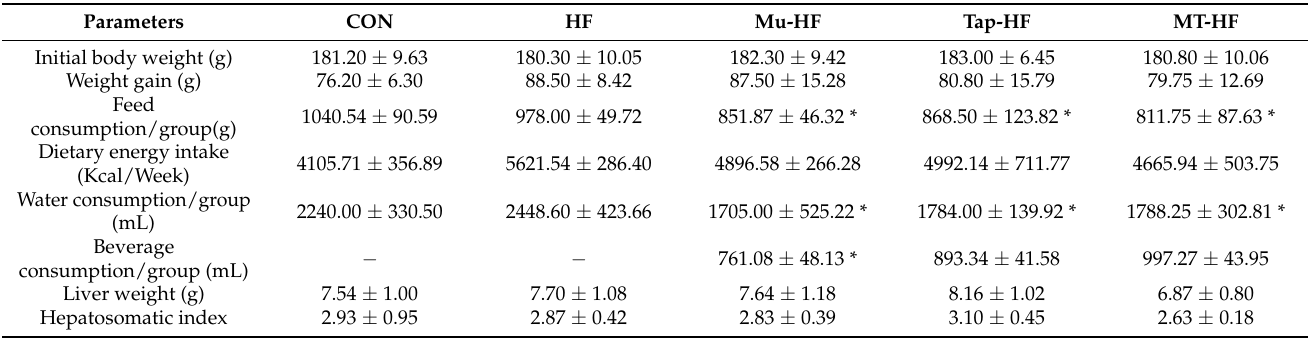
Table 2. Control of body weight, liver weight, diet intake in experimental